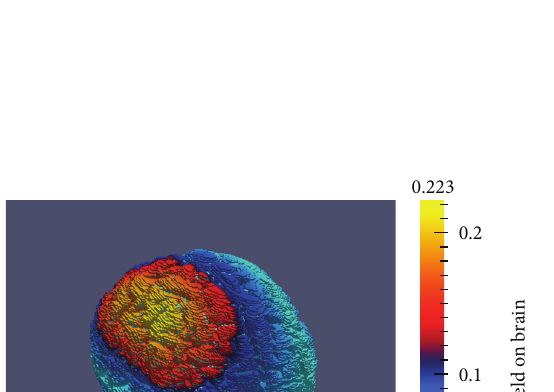
Figure 9: The total electric field distribution on bone.